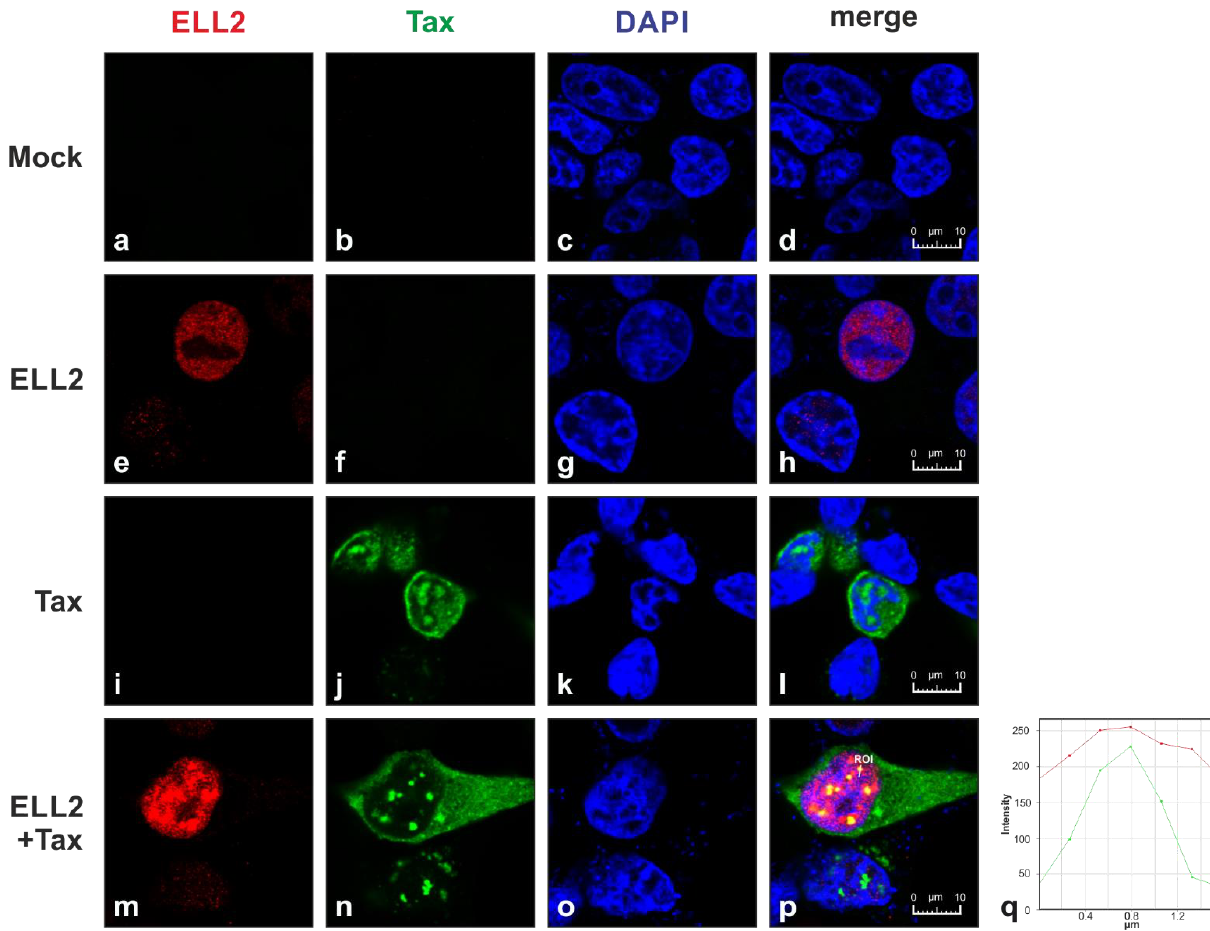
Figure 1. Tax-1 and ELL2 co-localize in dot-like structures in the nucleus . ( a – p ) Indirect immunofluorescence analysis of ELL2, Tax-1 and the nucleus was performed. 293T cells were transfected with expression plasmids pEF-ELL2-myc, pEF-Tax-1 (1 µ g each), both plasmids or the empty vector pEF-1 α (mock). After 24 h, cells were stained with primary mouse anti-Tax and rabbit anti-ELL2 antibodies, followed by anti-mouse Alexa Fluor 647 and anti-rabbit Alexa Fluor 555 antibodies, respectively. Staining of nuclei was performed using Prolong Gold reagent with DAPI (4,6-diamidino-2-phenylindole). Images were generated using confocal laser scanning microscope Leica TCS SP5. Images of ELL2 (red), Tax-1 (green), the nucleus (blue), and the merge of all three stains are shown. Scale bars indicate 10 µ m. Yellow dots indicate partial co-localizations of Tax-1 and ELL2. ( p ) A region of interest (ROI) is highlighted and ( q ) the graph shows the fluorescence intensities of Tax-1- and ELL2-specific fluorescence along the